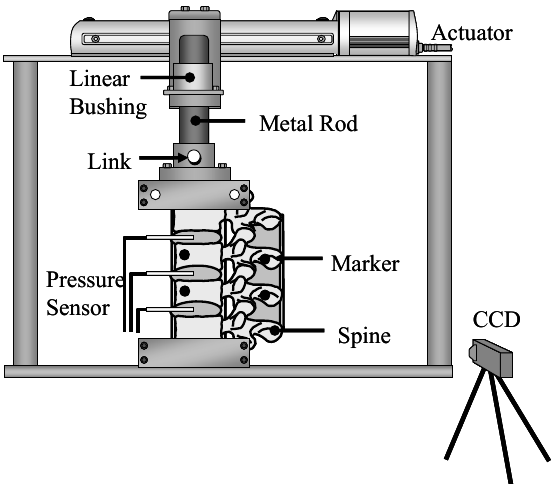
Fig. 2 A schematic diagram of the test configuration. This configuration enables to simulate sequential flexion and extension of the spine. A caudal vertebra is moved with the actuator, intradiscal pressure is measured with a pressure sensor, a segmental motion is tracked with a CCD camera.